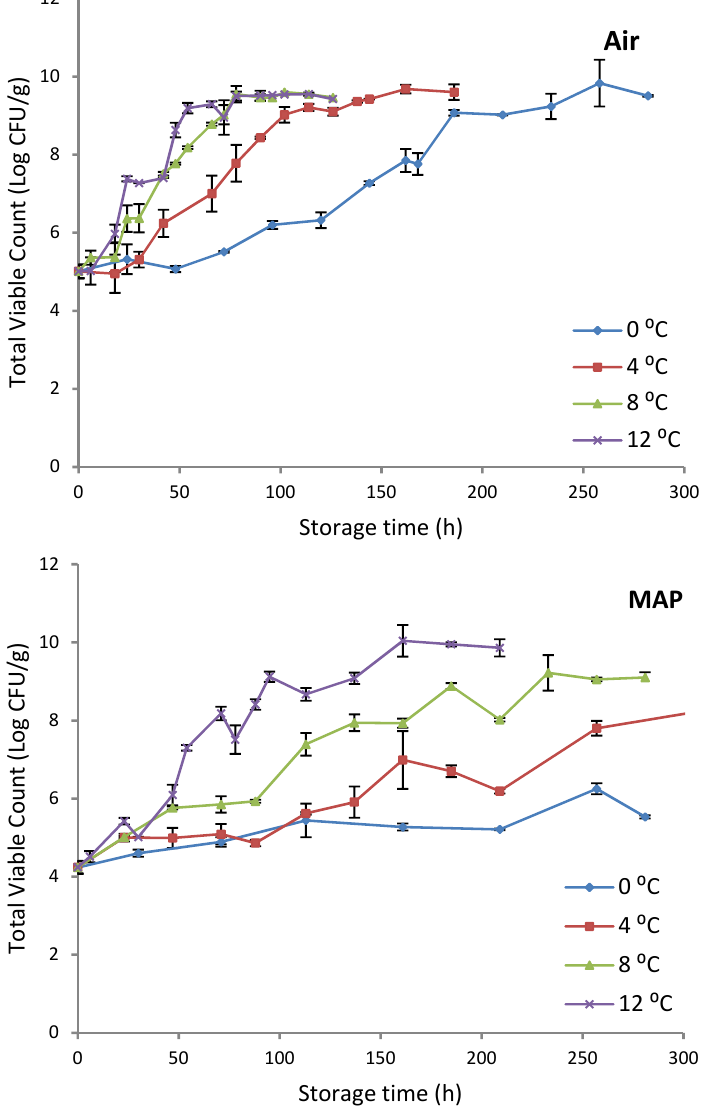
Figure 1. Changes in the population of total viable counts (TVC) during aerobic and MAP storage of gilthead sea bream fillets. Data points represent mean values ± standard deviation from duplicate packages analyzed per sampling point.